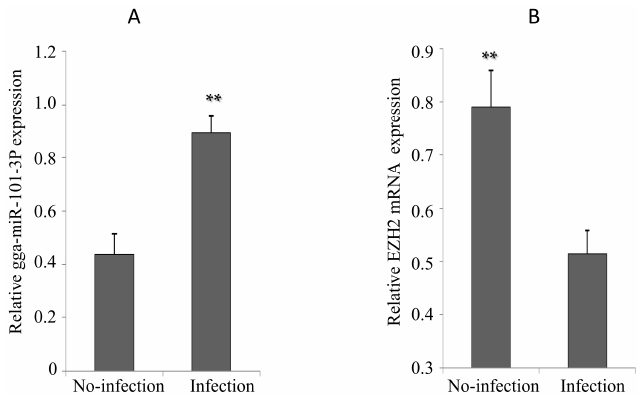
Figure 7. Effects of MG infection on the expression of gga-miR-101-3P and EZH2 in DF-1 cells. The DF-1 cells were infected by MG as described in section Material and Methods, and the total RNA was extracted. ( A ) gga-miR-101-3p expression was assessed by real-time quantitative reverse transcriptase polymerase chain reaction (RT-qPCR) using 5S-rRNA as an internal quantitative control; ( B ) EZH2 mRNA expression was assessed by RT-qPCR. GAPDH was used as an internal quantitative control. Three independent experiments were performed in triplicate, plotted data points referred to the means ˘ standard deviations and asterisks represented statistically significant differences (** p < 0.01).